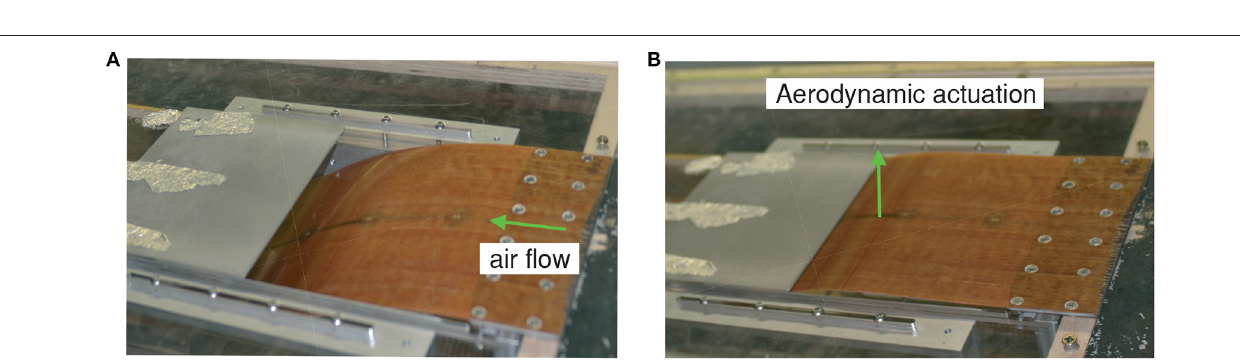
Frontiers in Applied Mathematics and Statistics |